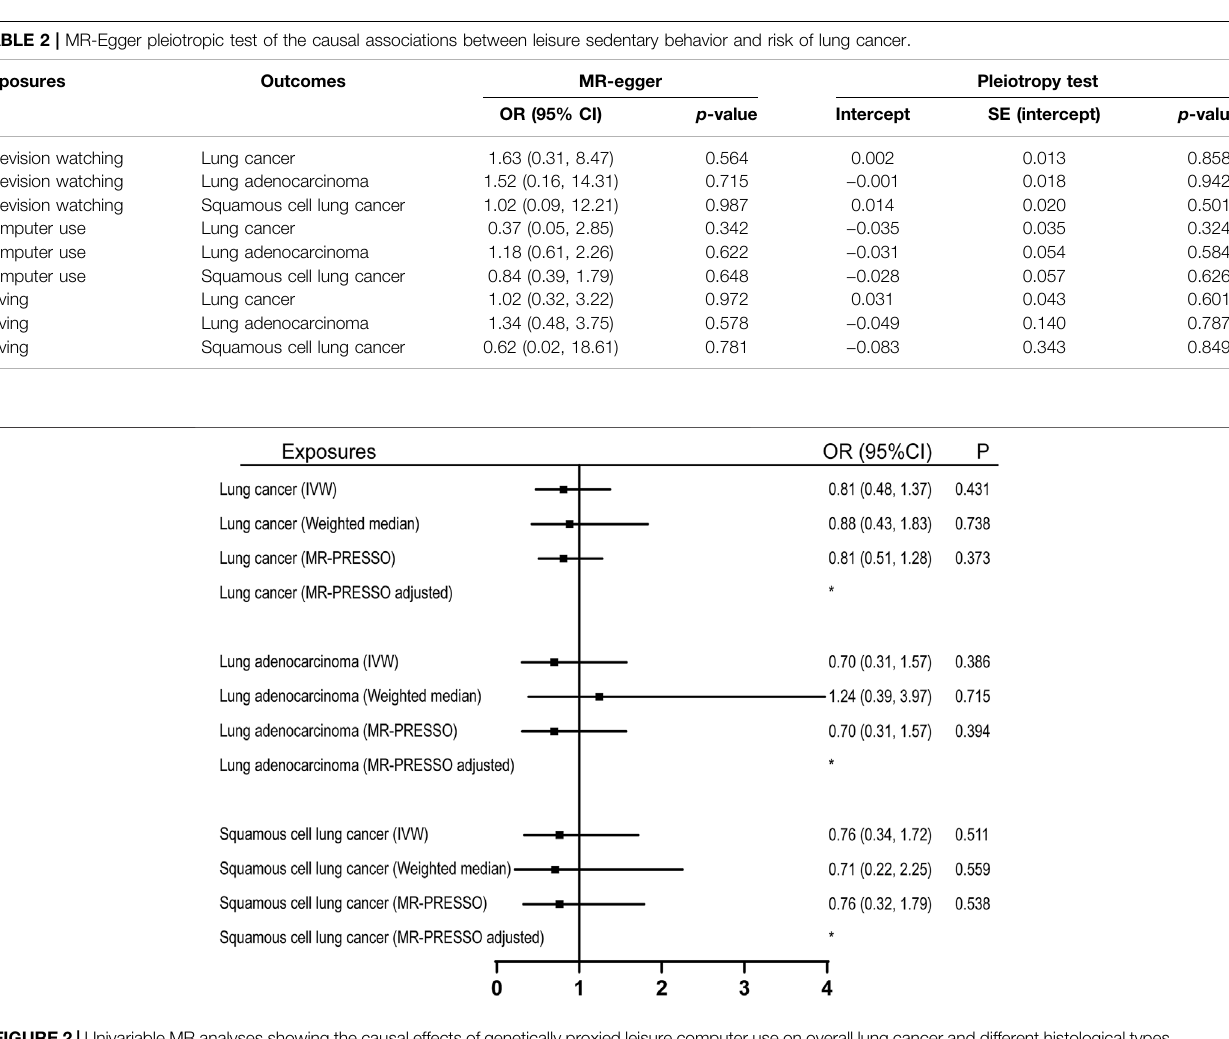
FIGURE 2 | Univariable MR analyses showing the causal effects of genetically proxied leisure computer use on overall lung cancer and different histological types with IVW, weighted median, and MR-PRESSO methods. *No outlier detected. IVW, inverse-variance weighted; OR, odds ratio; CI, con fi dence interval; MR, Mendelian